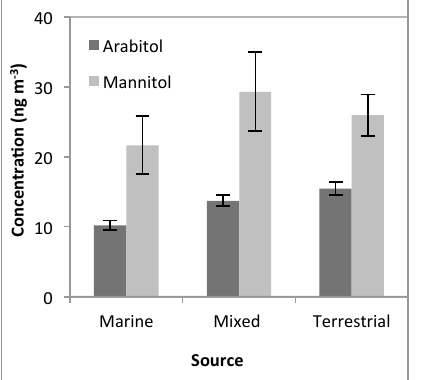
Fig. 9. Arabitol and mannitol concentrations according to source, broadly characterized to: marine environment (air mass that orig- inated from the Mediterranean Sea), terrestrial sources (air mass from inland environments) and mixed sources (air mass that are not classified as marine or terrestrial). Arabitol has the highest concen- trations when the samples are from terrestrial sources while manni- tol behaves different with highest concentrations from mixed envi- ronment.